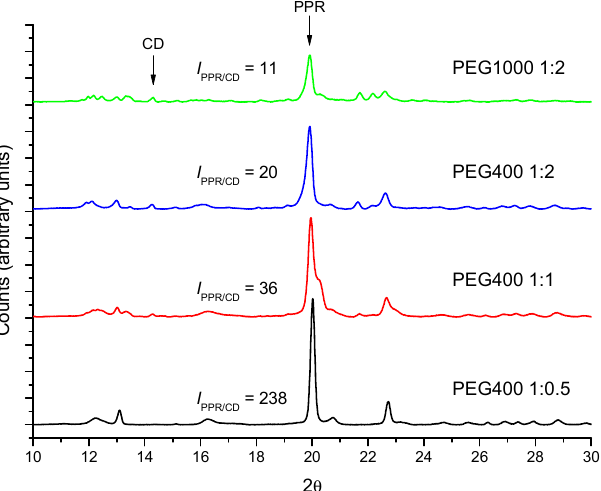
Figure 10. Comparison between the diffractograms of different molar ratios PEG400 and PEG1000 with α -CD after 24 h at 50 °C.